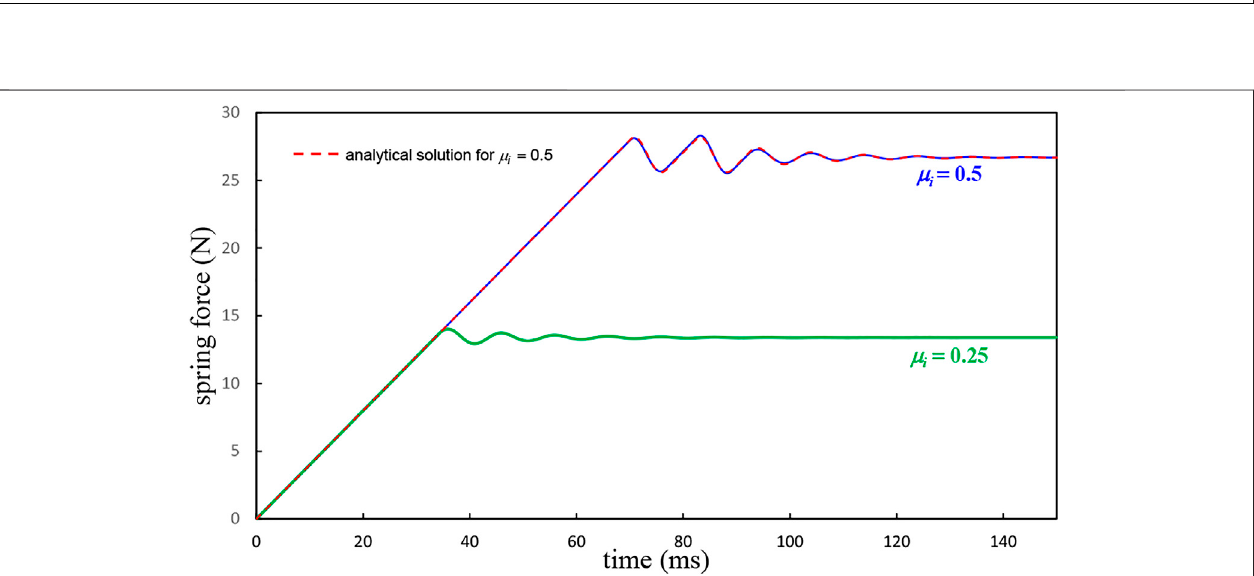
FIGURE 8 | Scaling of average pin displacement per event step as a function of the grid resolution.